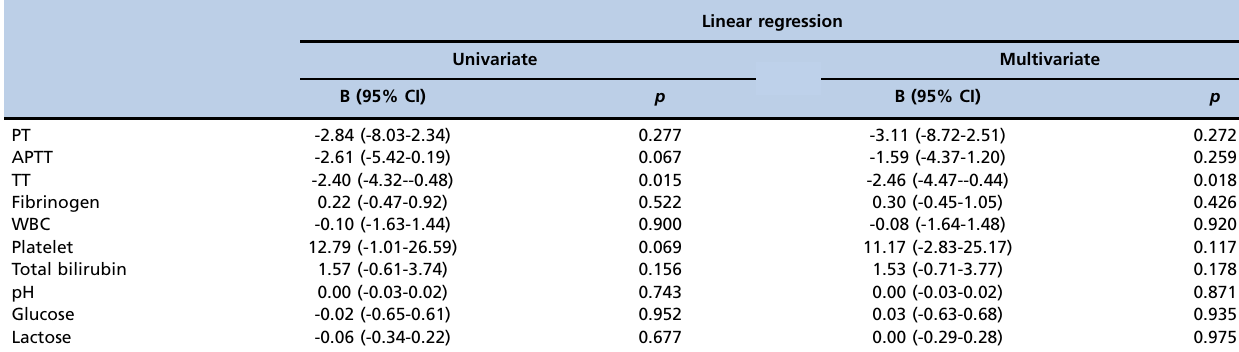
Table 5 - Univariate and multivariate linear regression